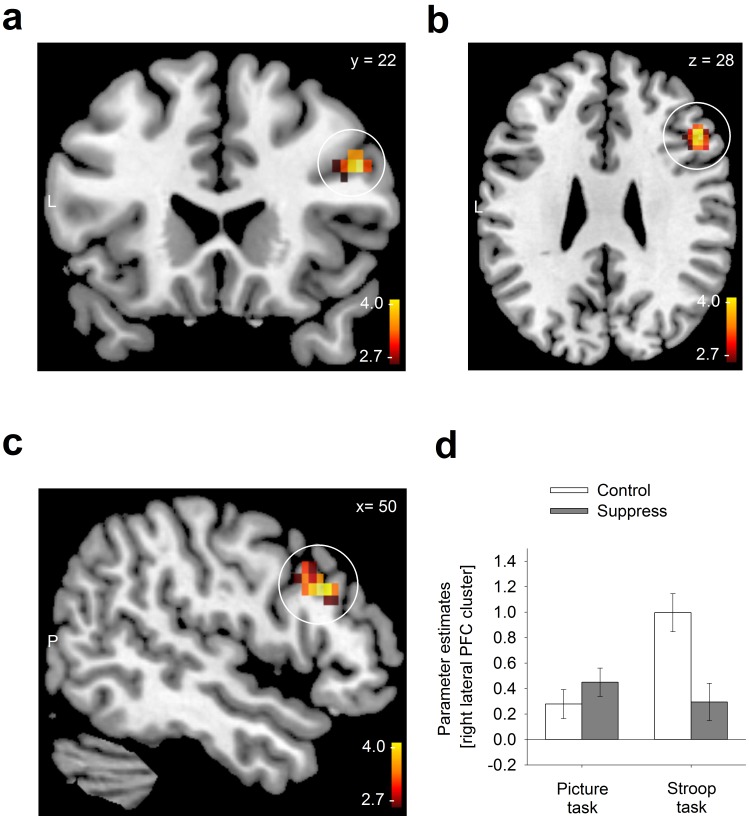
Aftereffects of self-control exertion on brain activity in the right lateral prefrontal cortex.(a–c) More activity in participants suppressing emotions during the picture-viewing task relative to control participants was followed by relatively less activity during the Stroop task in a cluster located in the right middle frontal gyrus (BA 9), extending into the inferior frontal gyrus (BA 9/45). t-values of the interaction contrast are color coded and displayed at a threshold of p = .005 (uncorrected) superimposed on a coronal (a), axial (b) and sagittal (c) slice of an anatomical template image. (d) Parameter estimates (arbitrary units) of the averaged activity of the right lateral PFC cluster for the experimental groups. Parameter estimates are extracted as first eigenvariate of all activated voxels in the cluster. Means ± SE are indicated.